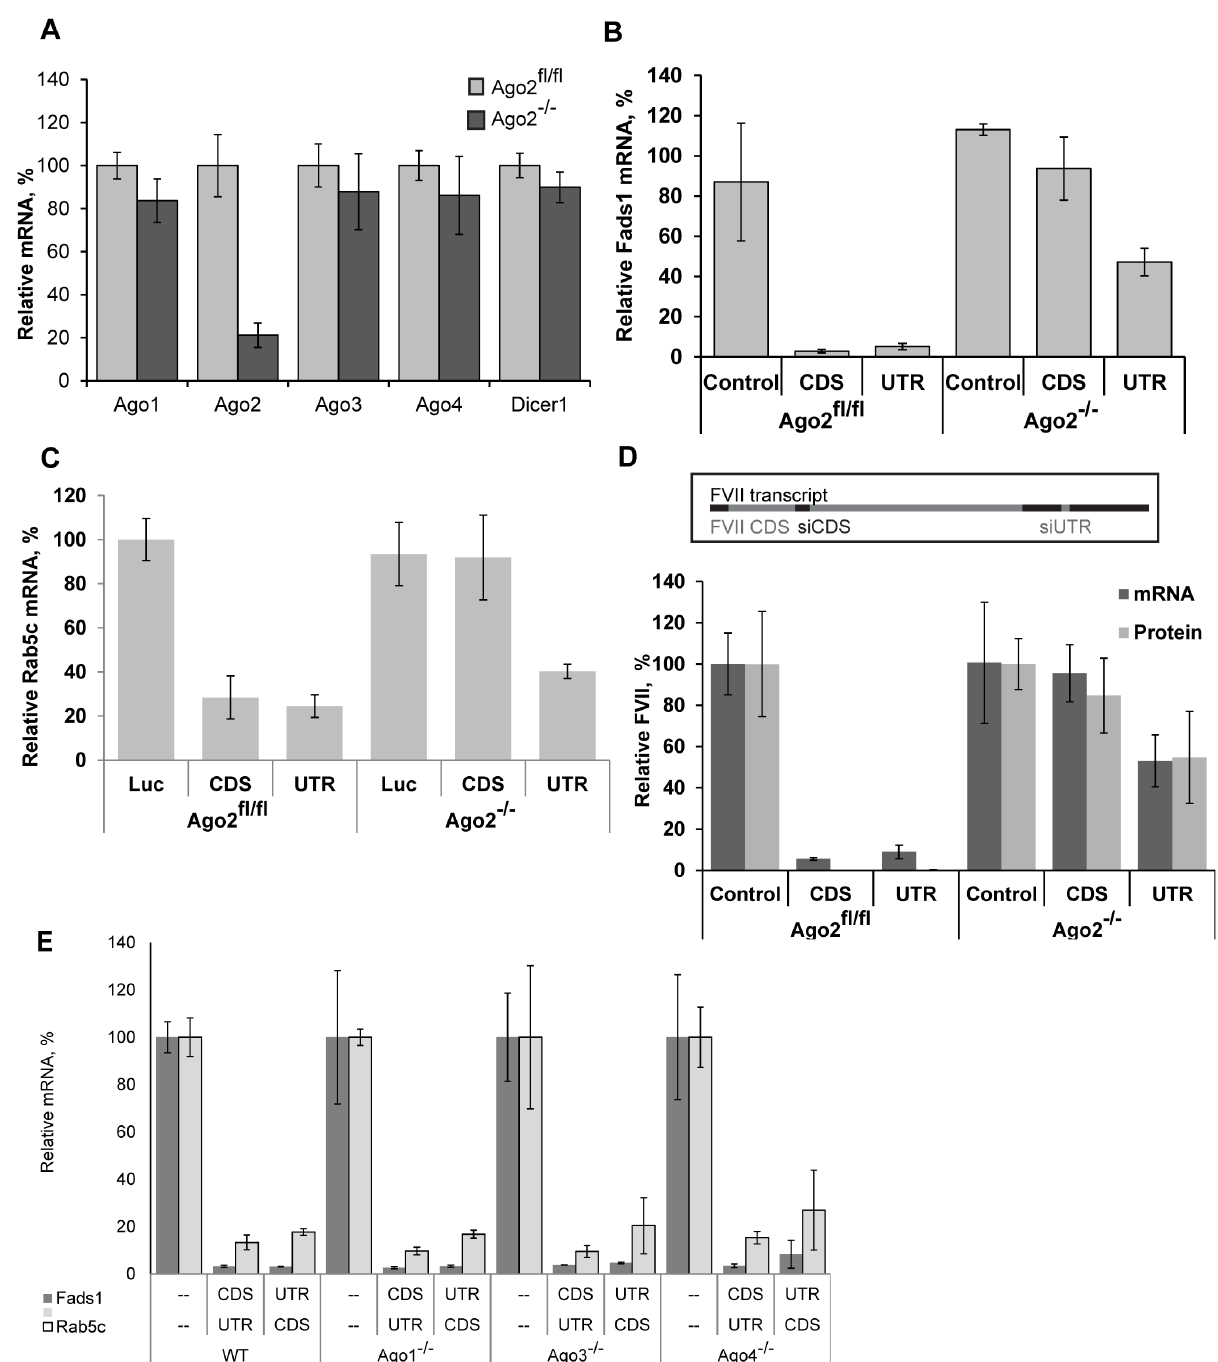
Figure 3. siRNAs targeting CDS and 3 9 UTR differ in their Ago2 dependence invivo . Data points are levels of mRNA measured by qRT-PCR in the livers (harvested 24 hours post-injection) of mice i.v.-injected with LNP-formulated siRNAs, as described in Materials and Methods, expressed as a percentage of mRNA levels in control siRNA-treated animals. (A) mRNA expression of Argonautes and Dicer1 in Ago2 fl/fl and Ago2 2 / 2 mouse liver (mean 6 s.d., n=4). (B) Levels of Fads1 mRNA in livers of Ago2 2 / 2 mice and Ago2 fl/fl mice (mean 6 s.d., n=2–3) treated with siRNAs targeting Fads1 CDS or 3 9 UTR at 0.5 mg/kg. (C) Rab5c mRNA levels after treatment with siRNAs targeting its CDS or 3 9 UTR-far at 1 mg/kg (mean 6 s.d., n=2–3). (D) FVII mRNA in the liver of animals treated with siRNAs (mean 6 s.d., n=4–5, doses: 0.8 mg/kg for siRNA targeting CDS and 0.4 mg/kg for siRNA targeting 3 9 UTR) and FVII protein in the serum quantified by chromogenic assay. (E) Activity of siRNAs targeting CDS and 3 9 UTR in the absence of Ago1, 3, or 4. Legend in the bottom left corner of the graph also indicates the line in the X-axis describing the treatment type by gene (mean 6 s.d., n=3). Mice knockout for different individual Argonaute genes and C57BL/6 control animals were i.v.-injected with one of two combinations of LNP- formulated siRNAs targeting Fads1 and Rab5c (CDS-targeting for one gene, at 0.8 mg/kg and 3 9 UTR-targeting for the other gene, at 0.4 mg/kg) or with control Luciferase siRNA at 1.2 mg/kg.